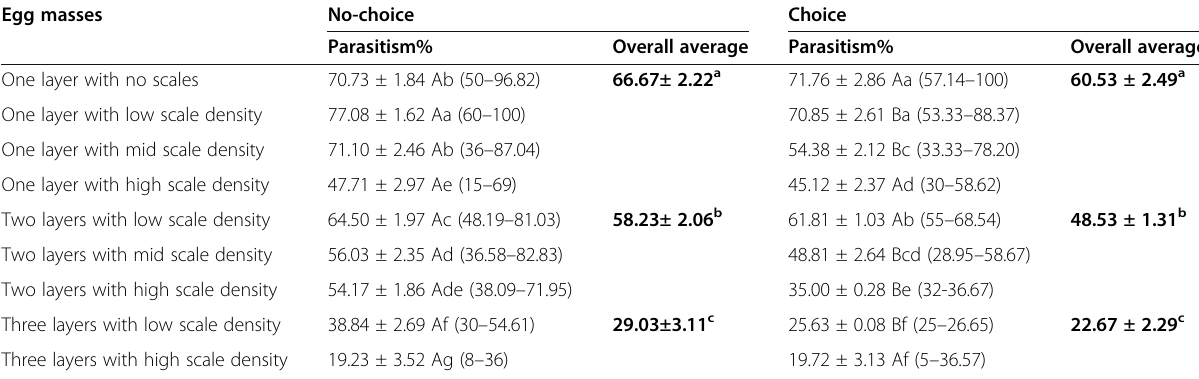
Table 1 Percentages of parasitism of T. bactrae on S. littoralis egg masses with different physical characteristics in a no-choice and choice tests